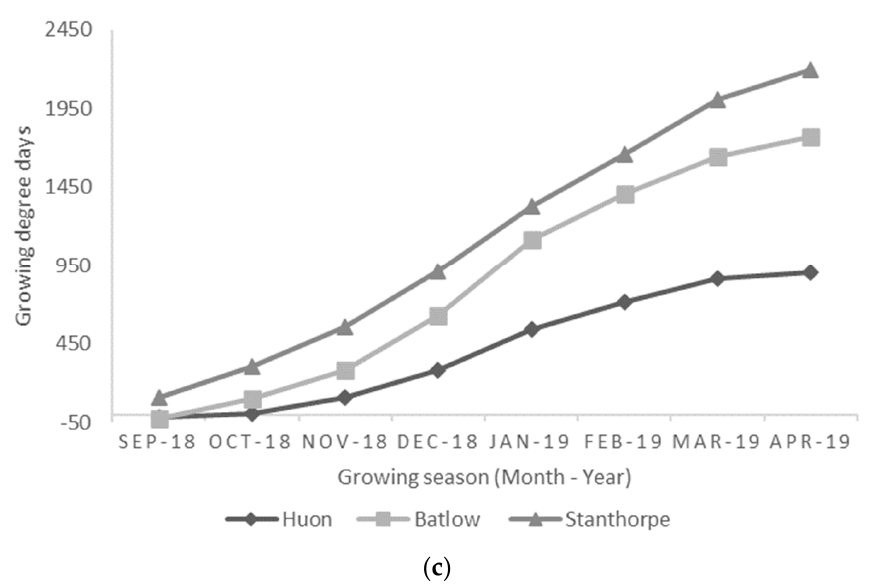
Figure 3. Weather data for each growing region during the 2018/2019 growing season including; monthly mean minimum and maximum temperature (°C) ( a ), mean monthly solar exposure (MJ/m 2 ) ( b ) and accumulated growing degree days (base 10 degrees) ( c ).